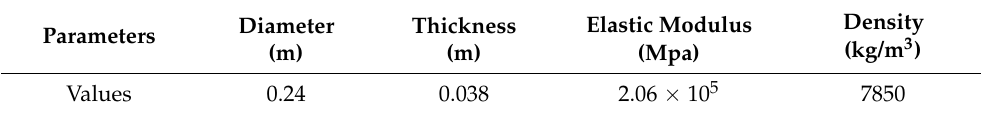
Table 3. Disk properties for the rotor Table 2. Diameters of the shafts.